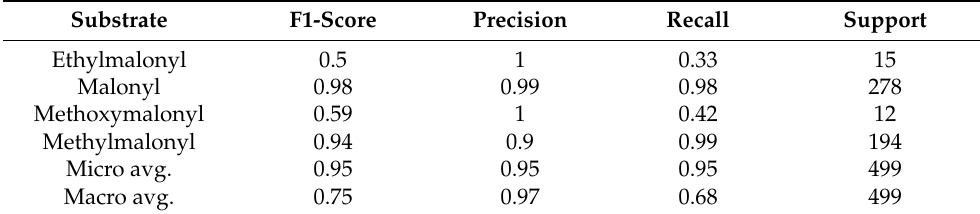
Table 4. Performance for each substrate for AT-domain classification.